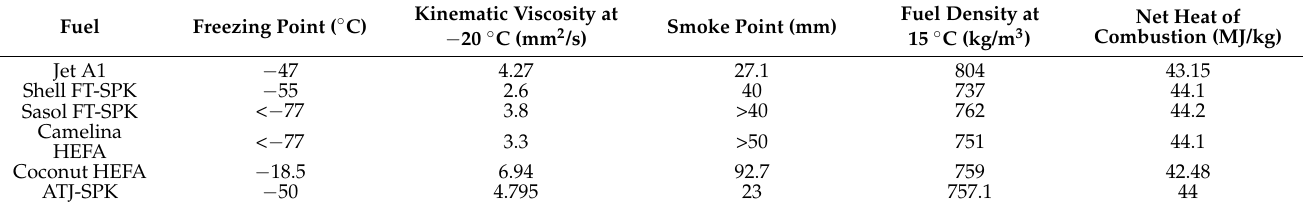
Table 1. General properties of the most common bio-fuels compared with jet-A1.